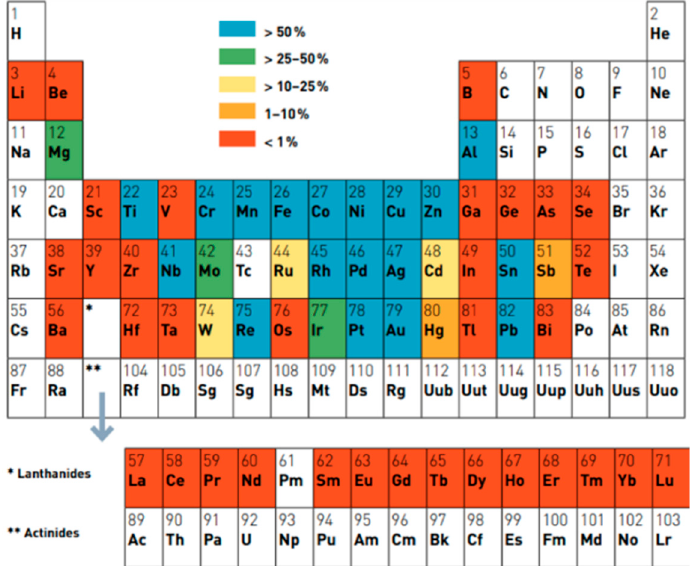
Figure 4. End-of-life recycling rate of some elements of the periodic table. Adapted with permis- sion from [109]. Copyright UNEP, 2011.